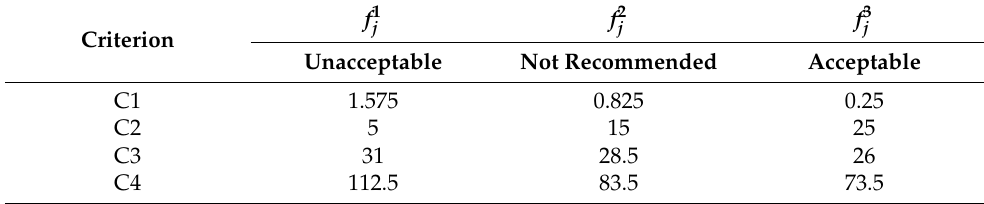
Table 5. Standard data midpoints.